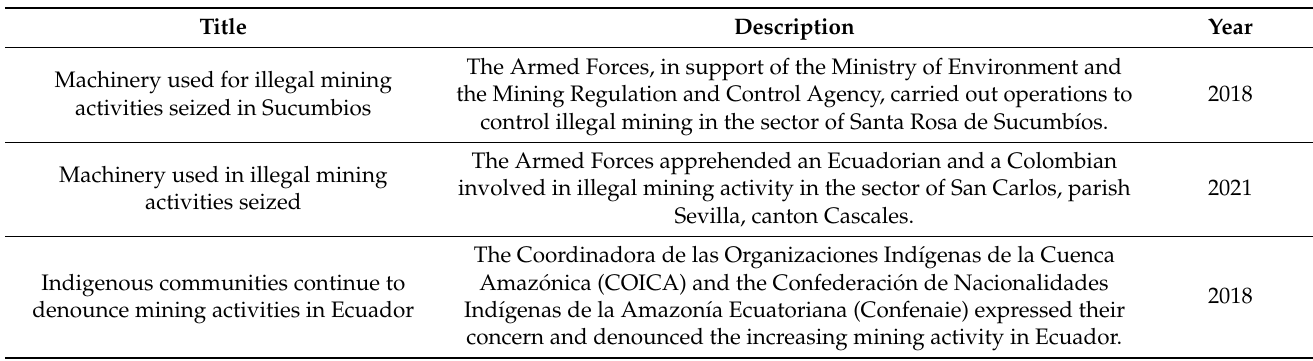
Table 6. Illegal ASLGM activities in the Amazon region of